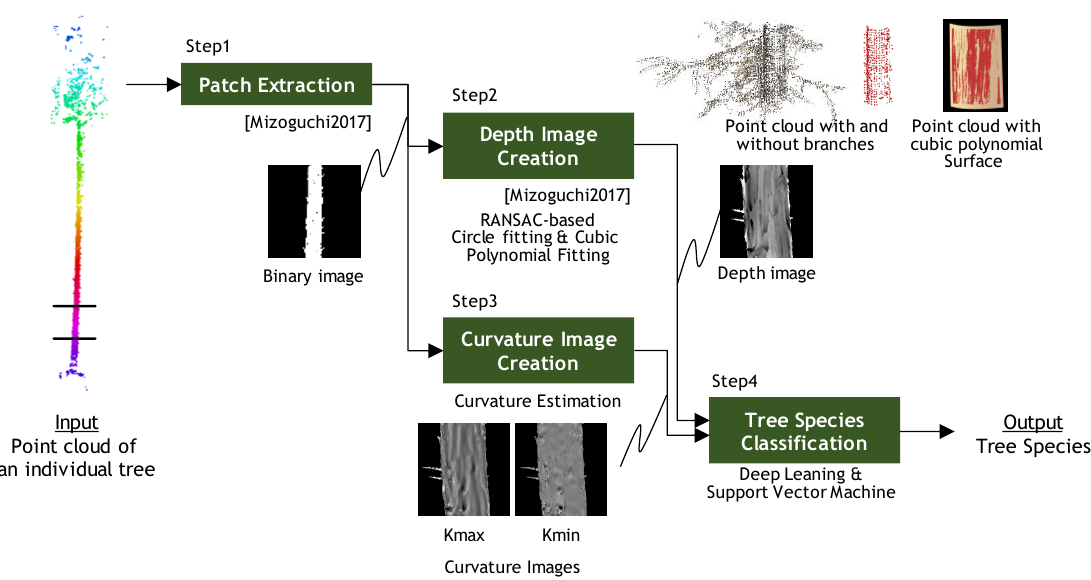
Figure 3. Overview of our proposed method